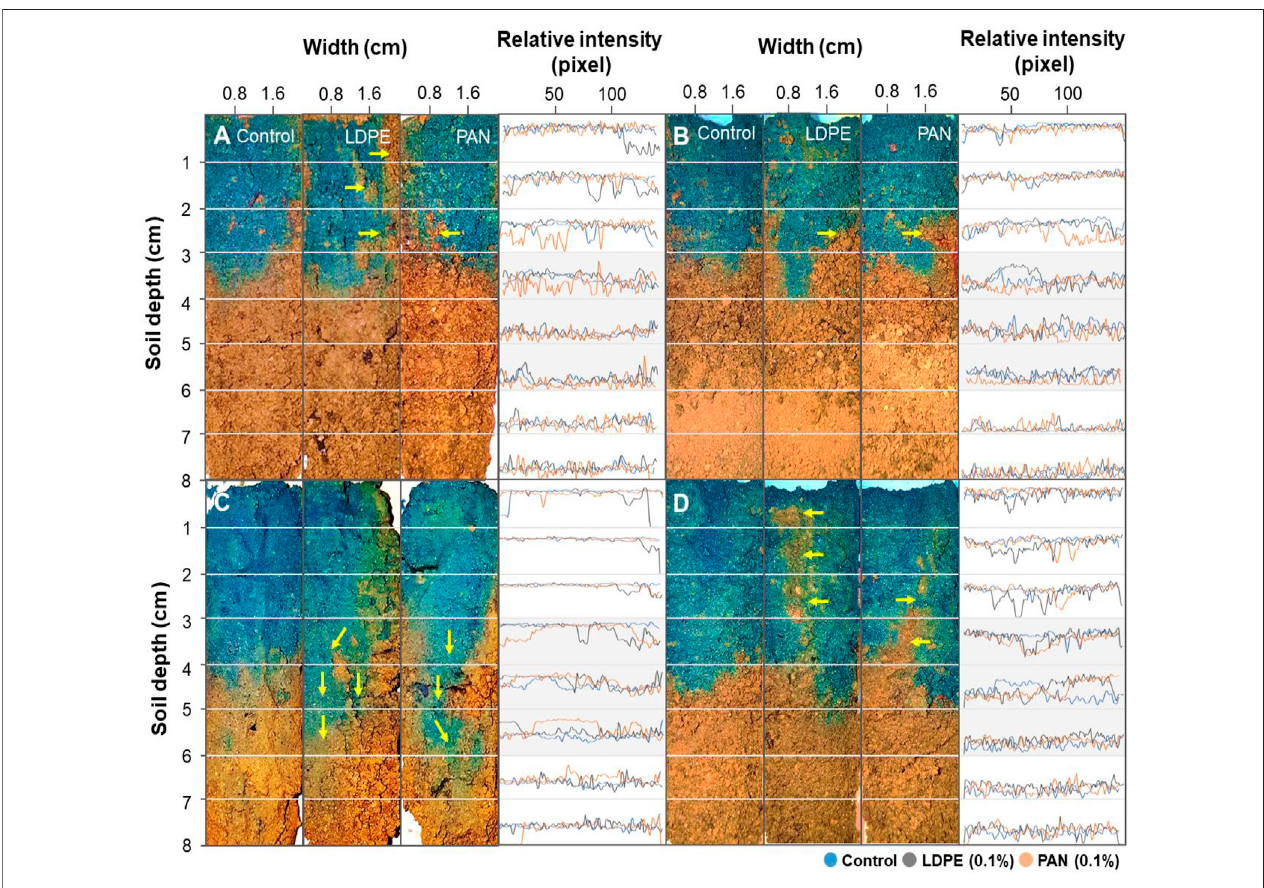
FIGURE 3 | In fi ltrated dye stain patterns for vertical soil pro fi les. Each soil column was incubated for 0 days (A,C) and 60 days (B,D) , and irrigated either at a low level (A,B) or with higher water volume (C,D) .